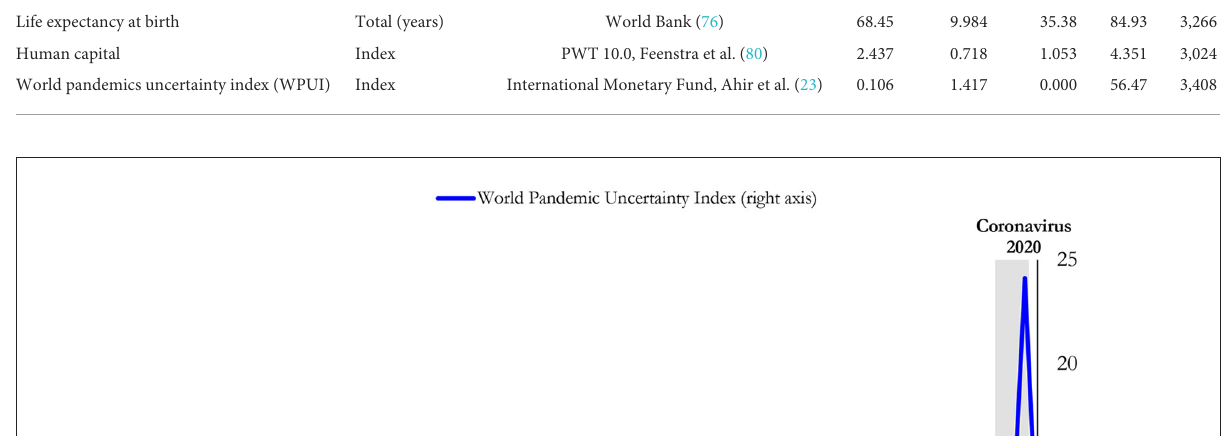
also finds that the COVID-19 pandemic decreases the fertility rate in Hong Kong and South